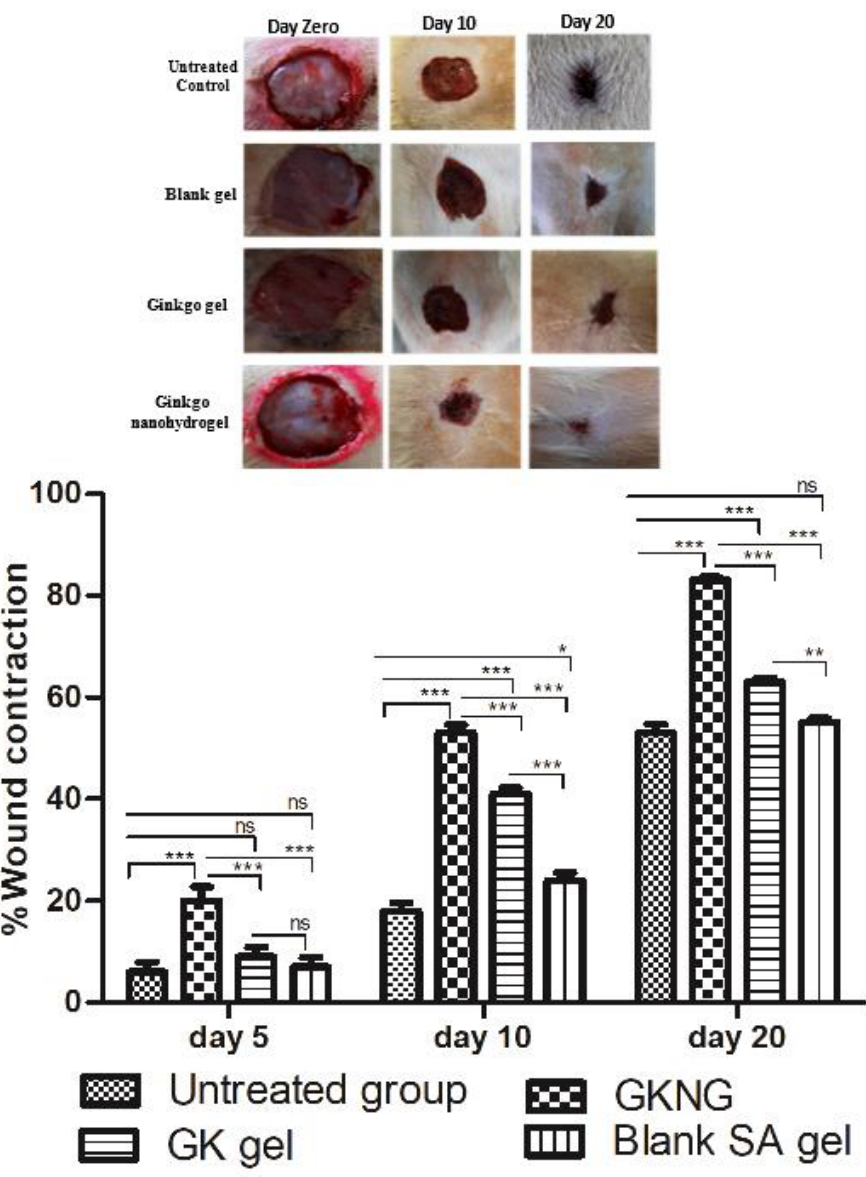
Figure 8. Effects of GKNG, GK gel, and blank SA on the wound contraction. Values are represented as mean ± SD (n = 4). Statistical analysis was performed by one-way ANOVA followed by Tukey’s multiple comparison test. ‘***’, ‘**’, and ‘*’ refer to p < 0.001, p < 0.01, and p < 0.05 and represent significant differences between the treatment and untreated groups. ‘ns’ refers to a nonsignificant difference between the treatment groups and untreated groups.